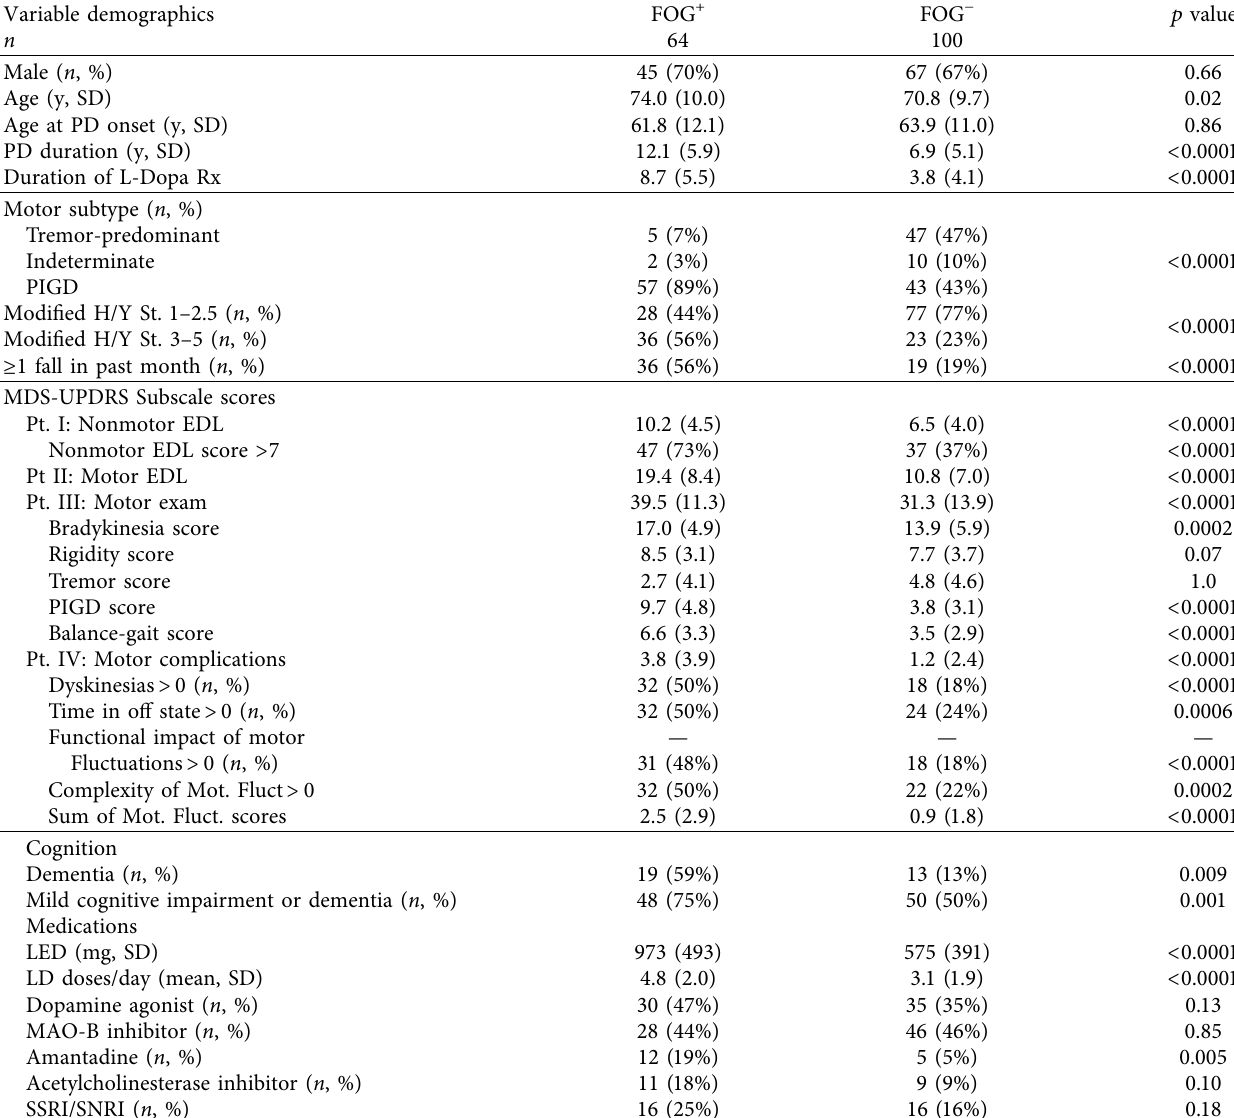
Table 1: Subject characteristics in relation to freezing of gait.